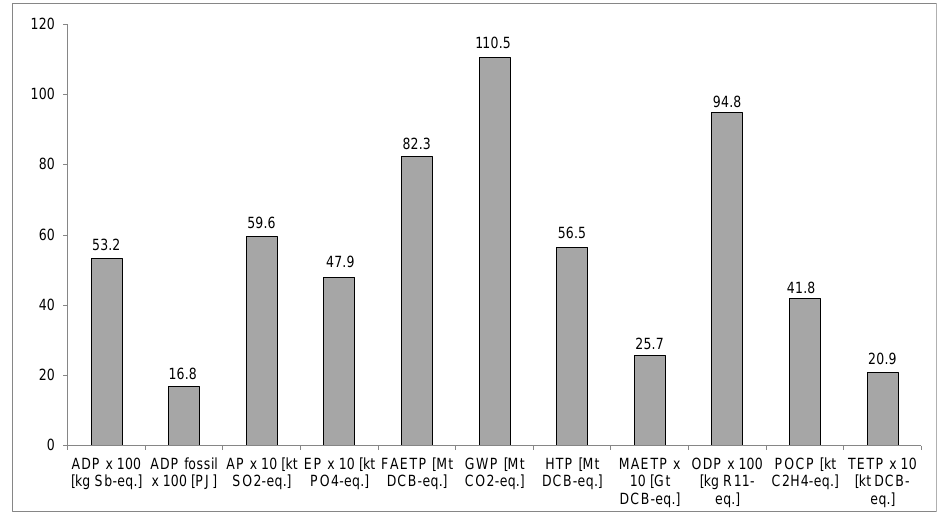
Figure 7. Total annual environmental impacts for the base year (2010). [For impacts nomenclature, see Figure 3.].